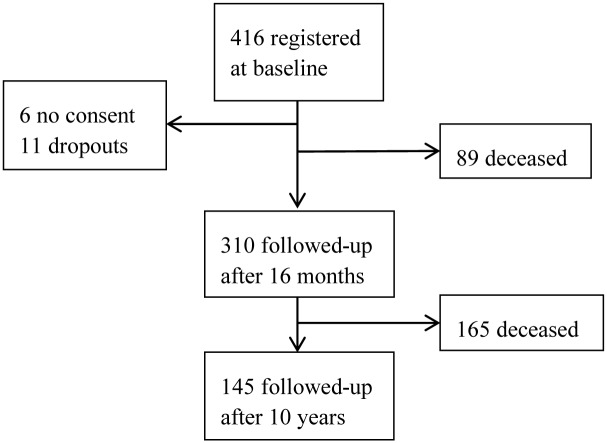
Participant flow chart from inclusion to the 10-year follow-up.